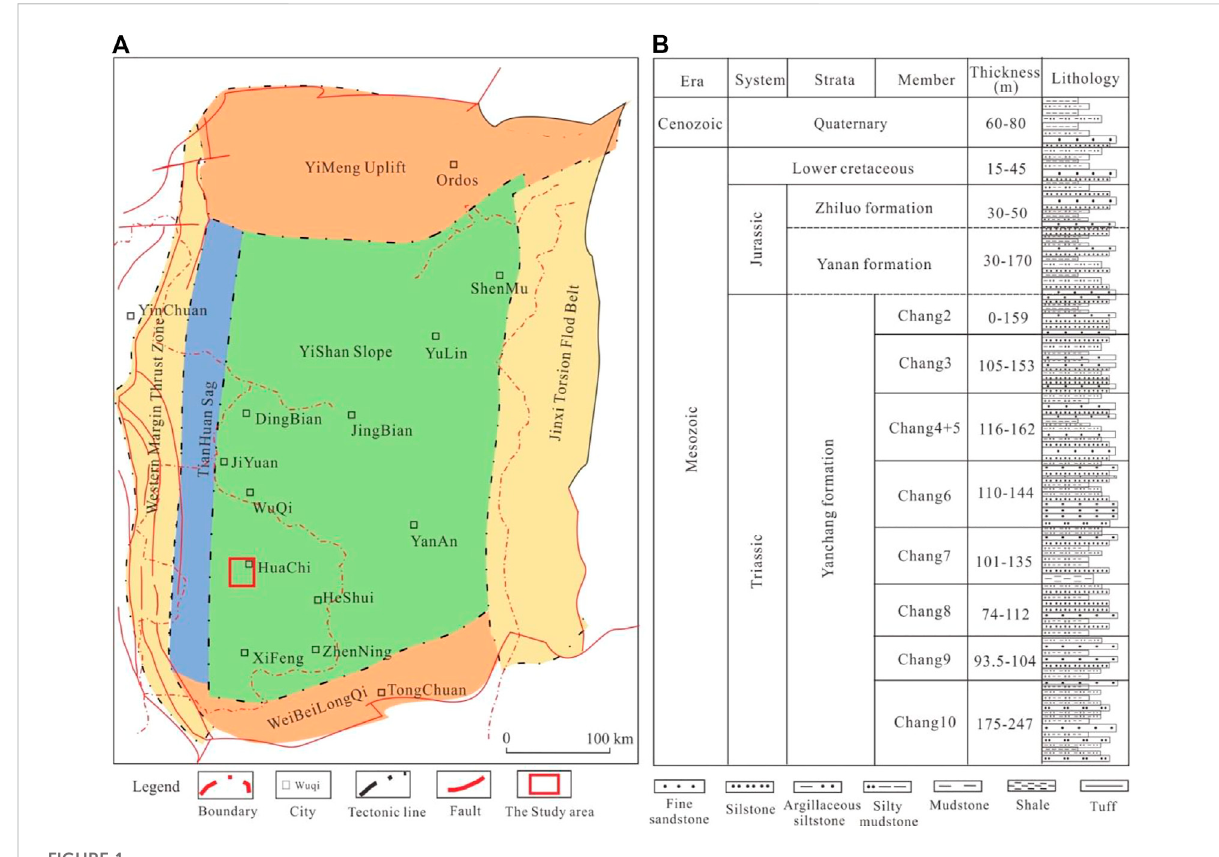
FIGURE 1 Location of study area (A) and division of stratigraphic units of Yanchang Formation (B)